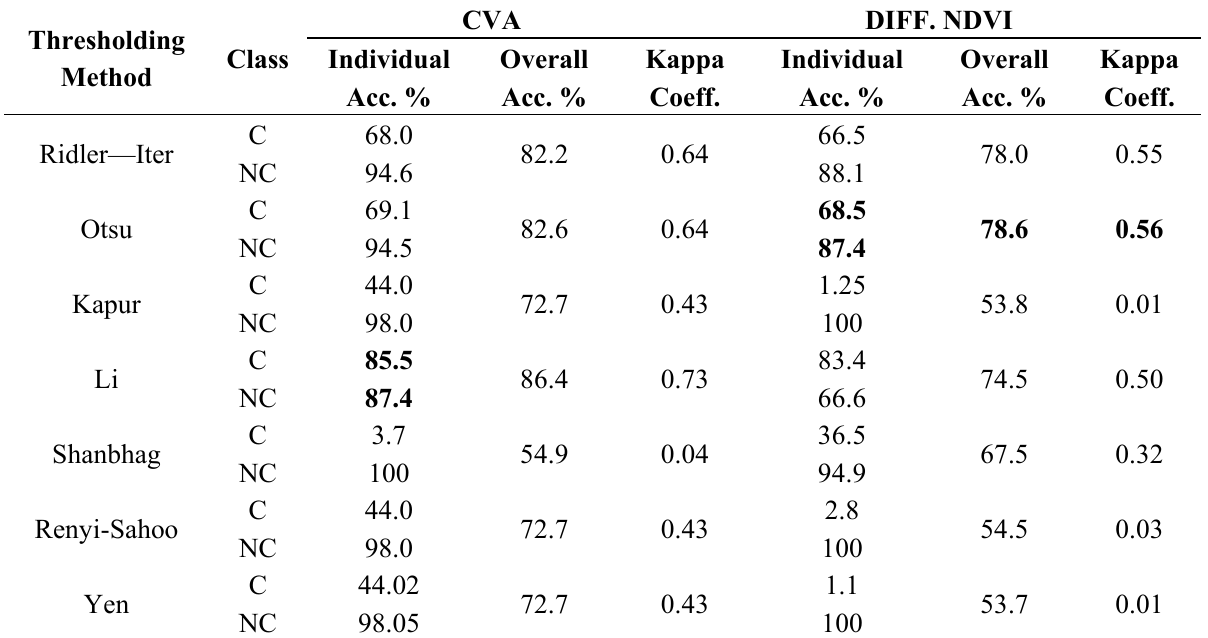
Table 1. Individual and global accuracies obtained for the thresholded indices corresponding to level